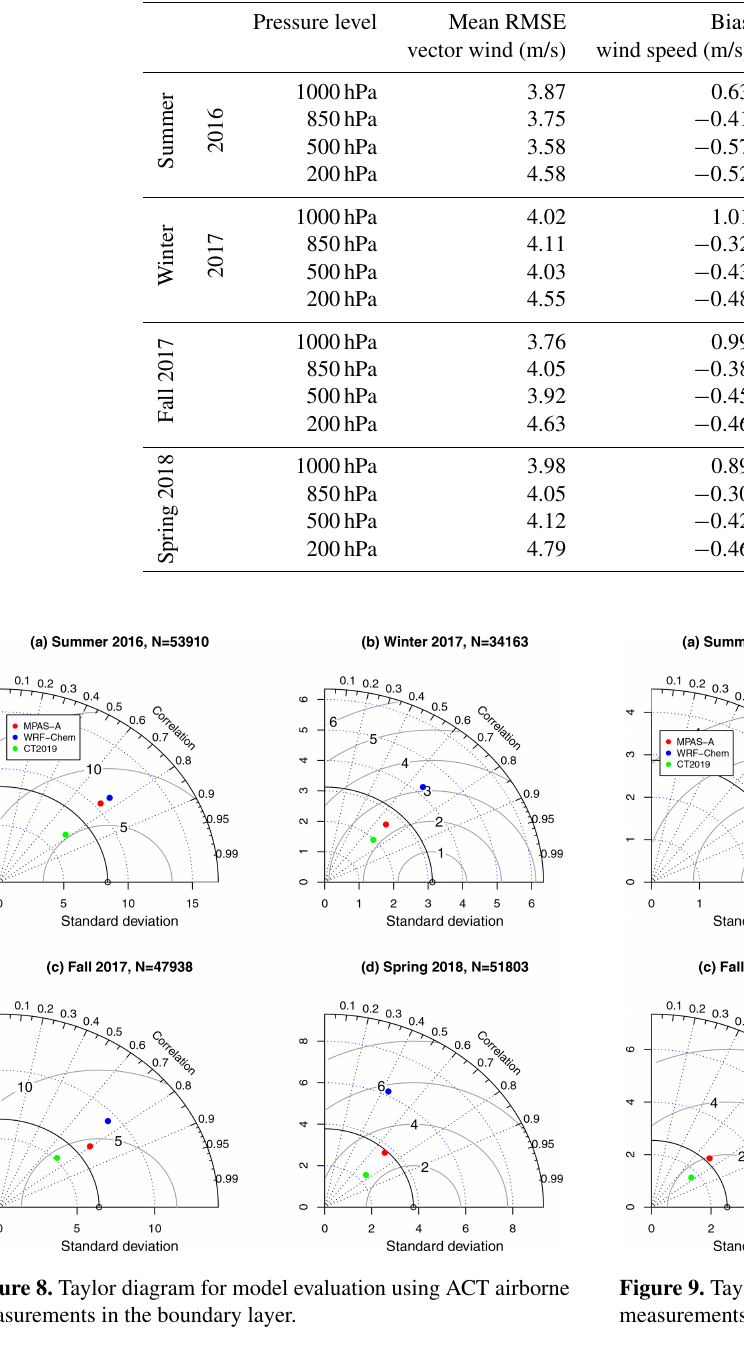
Table 10. Evaluation of the simulated horizontal wind of MPAS-A using radiosonde observations at 457 stations located across the globe. Wind speed and direction are compared at 00:00 and 12:00UTC at four pressure levels (1000, 850, 500, and 200hPa) for each day of the MPAS-A simulation. Note that the number of data samples ( N ) is smaller at 1000hPa because some stations are located above that pressure level.